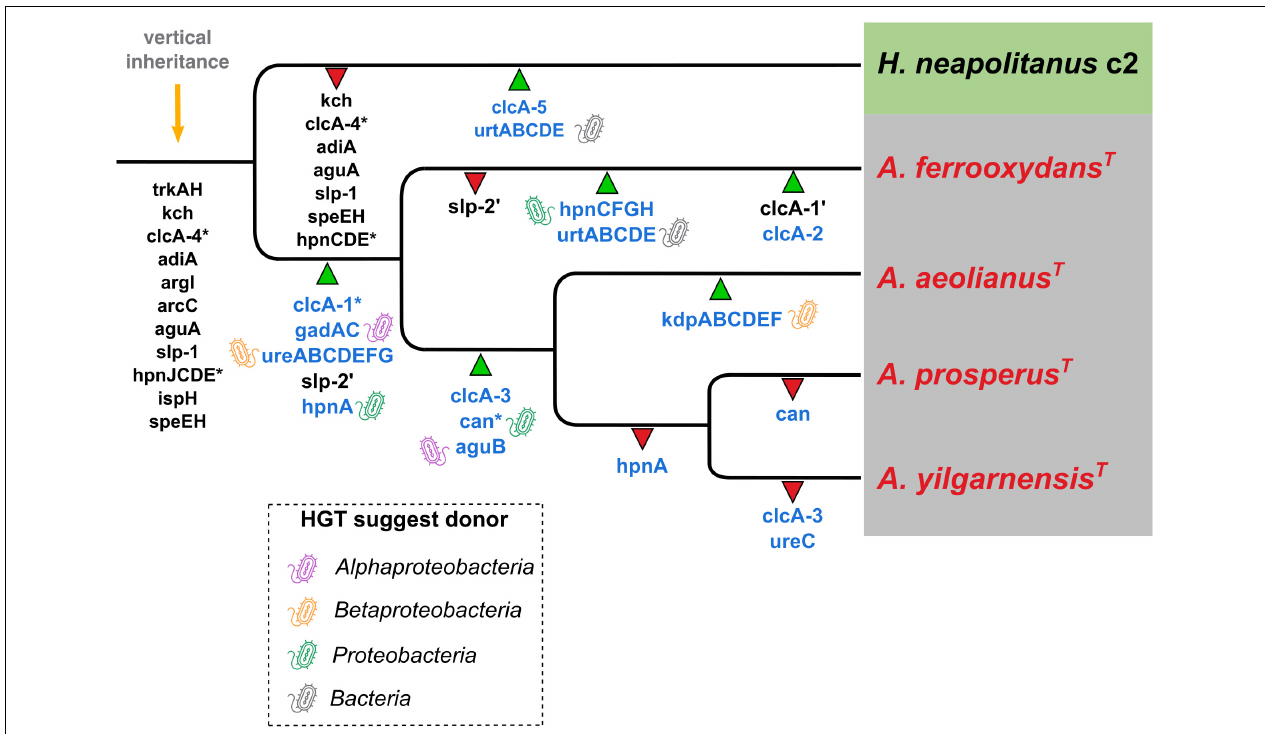
FIGURE 8 | Inferred phylogenetic distribution of acid resistance genes. Green triangles represent gene gain events (the ’ in slp and clc A genes represent a duplication event) and red triangles represent gene loss events. Gene names in blue indicate hypothesized HGT events (* marks the uncertain origin for that gene) and the bacteria-icon represents the putative origin of those events. Orange arrow = predicted genes inherited by vertical